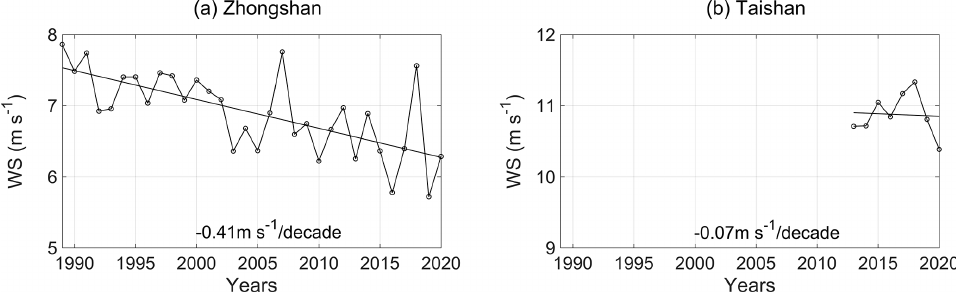
Figure 11. Annual variation in wind speed at Zhongshan ( p < 0.05) and Taishan ( p < 0.05). The calculation periods for these site are the same as for Fig.